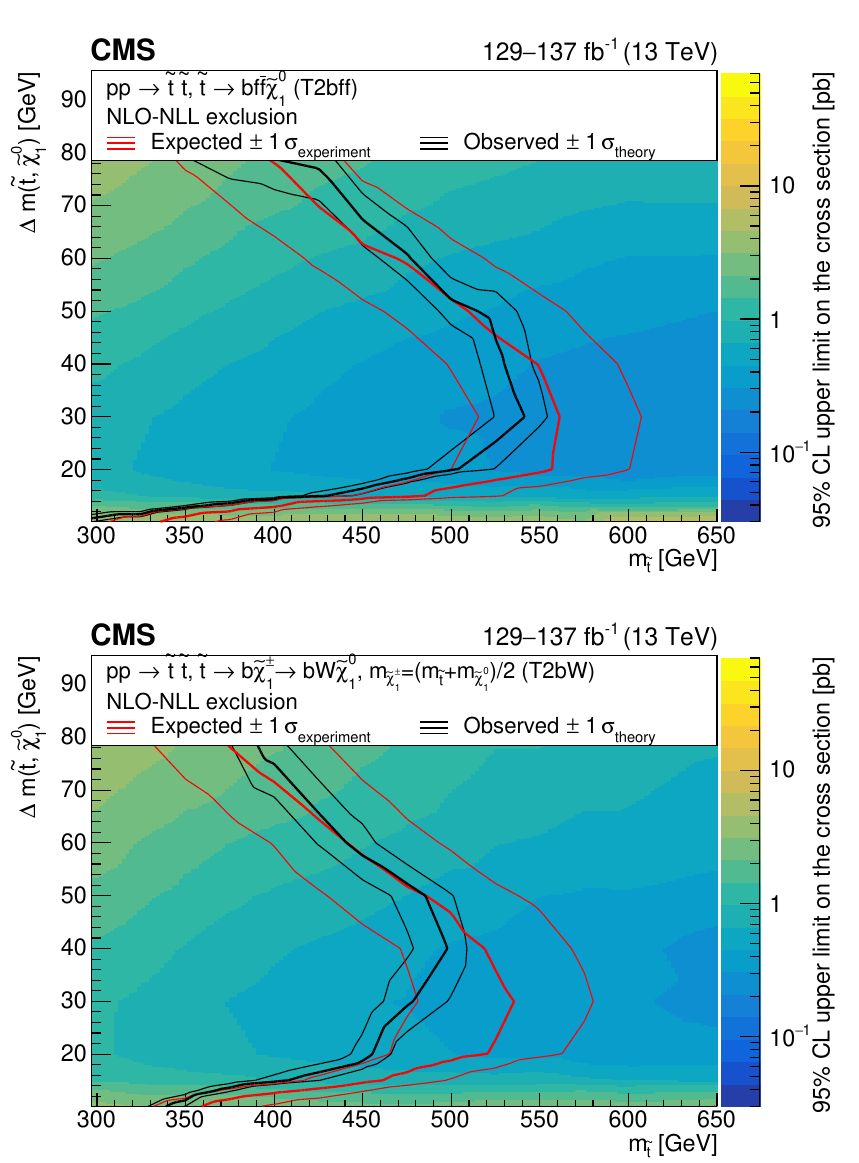
Figure 10 . The observed 95% CL exclusion contours (black curves) assuming the NLO+NLL cross sections, with the variations (thin lines) corresponding to the uncertainty in the cross section for 0 the T2b ff (upper) and T2bW (lower) simplified models. The red curves present the 95% CL e c 1 expected limits with the band (thin lines) covering 68% of the limits in the absence of signal. The range of luminosities of the analysis regions included in the fit is indicated on the